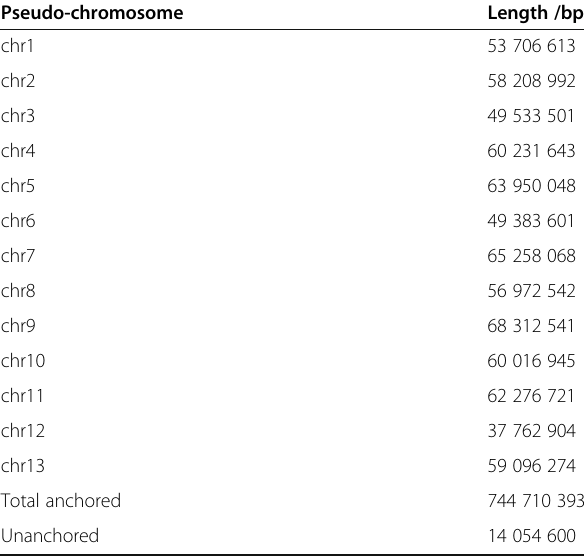
Table 1 The statistics of pseudo-chromosome length